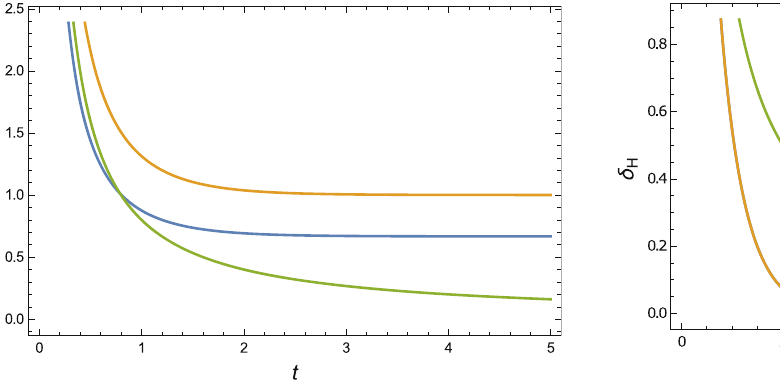
Fig. 11 Perturbation of the Hubble parameter against cosmic time. The yellow curve represents the evolution for both (i) the constant jerk parameter case and (ii) the jerk proportional to inverse square of hub- ble parameter case. The green curve represents the evolution for the . The H 2 reconstructed models from a slowly varying